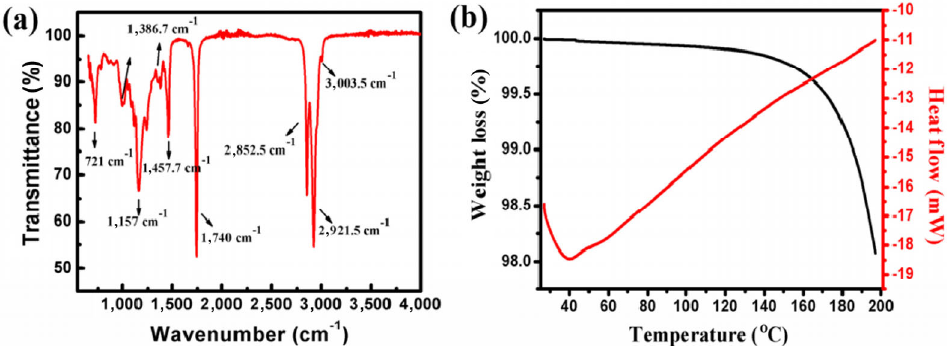
Fig. 3 (a) IR spectrum and (b) TGA-DTA curve of vegetable